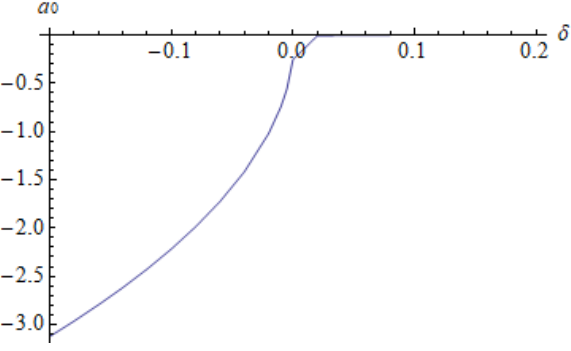
Figure 7. Variation of a 0 with D = 0 for δ [−0.2, 0.2] , given by Equation (77).